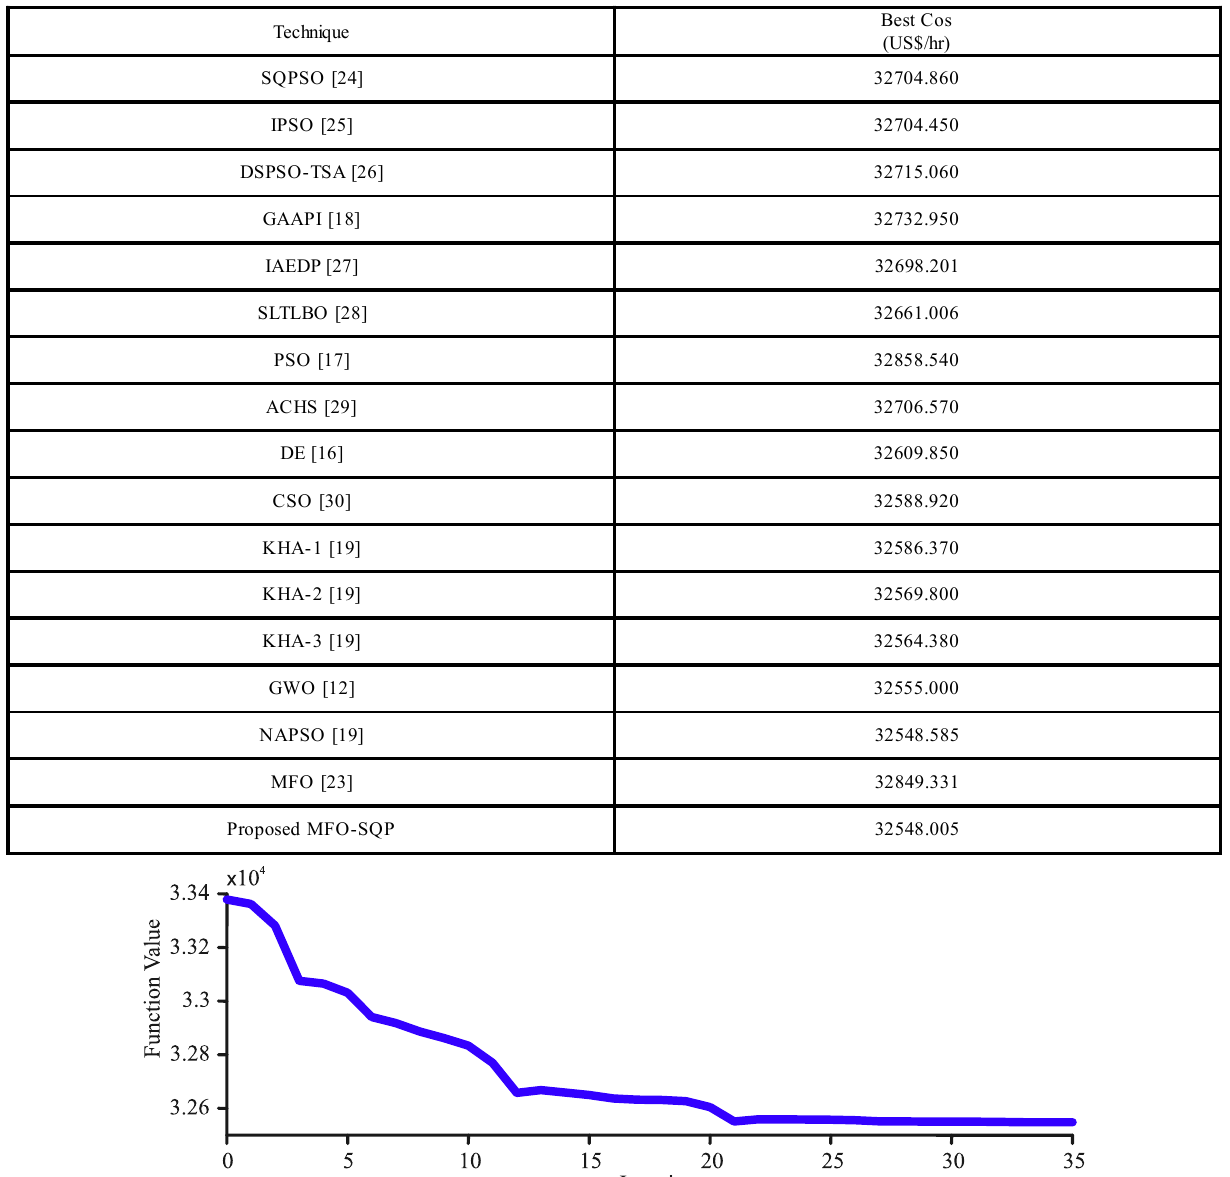
TABLE 4. COMPARISON OF 15 UNITS TEST SYSTEM